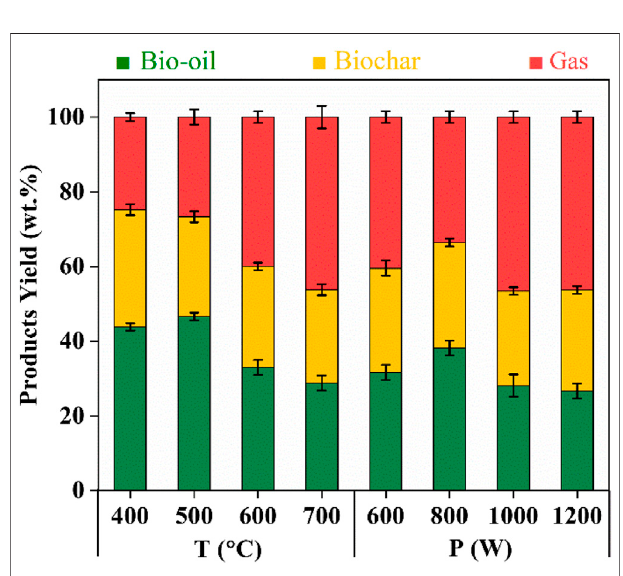
FIGURE4| Distributionofpyrolysisproductsfromcornstrawatdifferent temperatures and power.